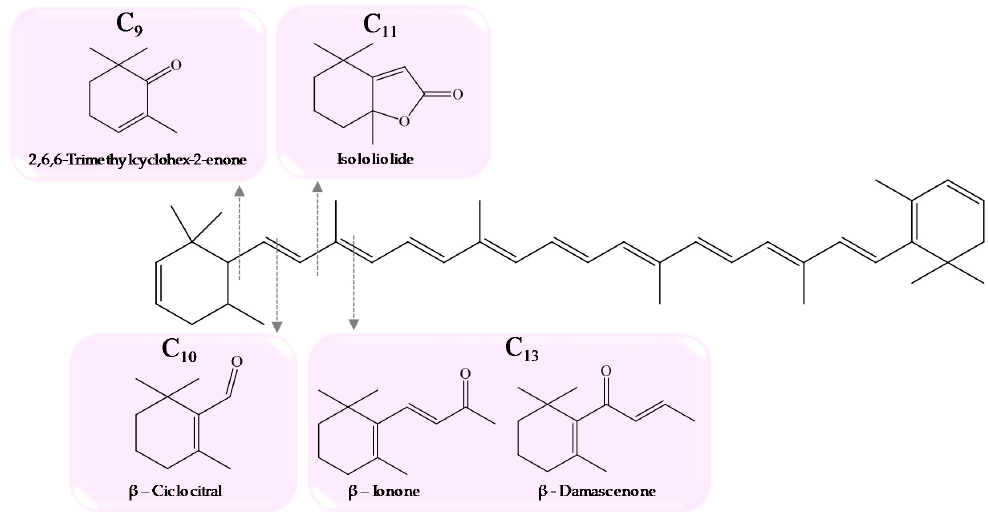
Figure 3. Formation of C 9 , C 10 , C 11 , and C 13 norisoprenoids from breakdown of carotenoids [18].